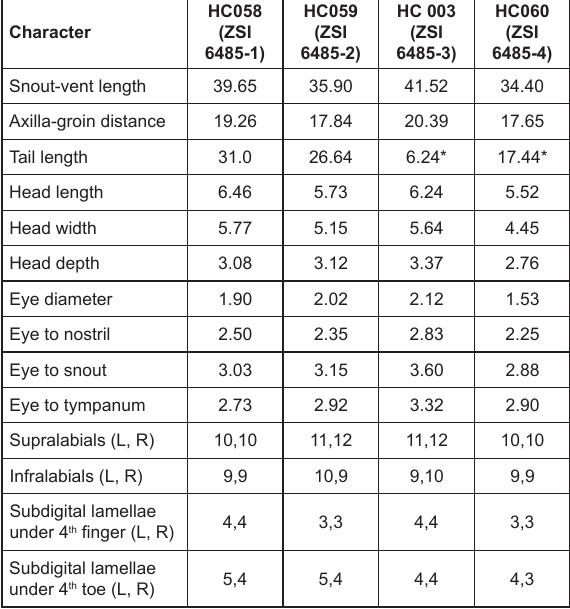
Table 1. Meristic and metric characters of four specimens of Hemiphyllodactylus typus from the Andaman Islands. (All measurements in